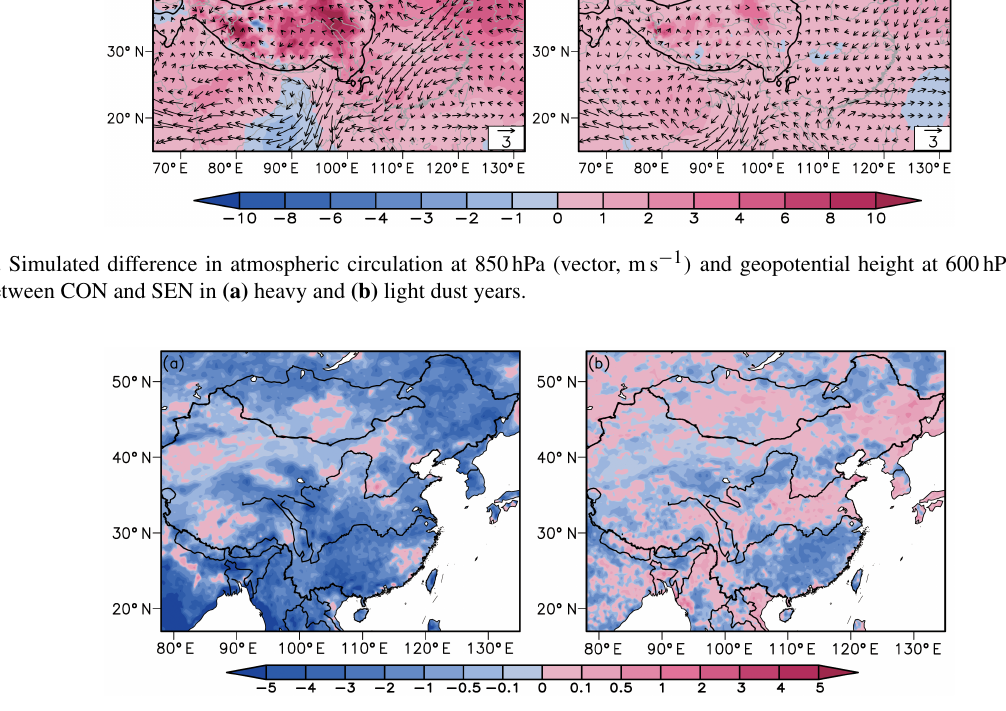
Figure 12. Simulated difference in summer precipitation between CON and SEN in (a) heavy and (b) light dust